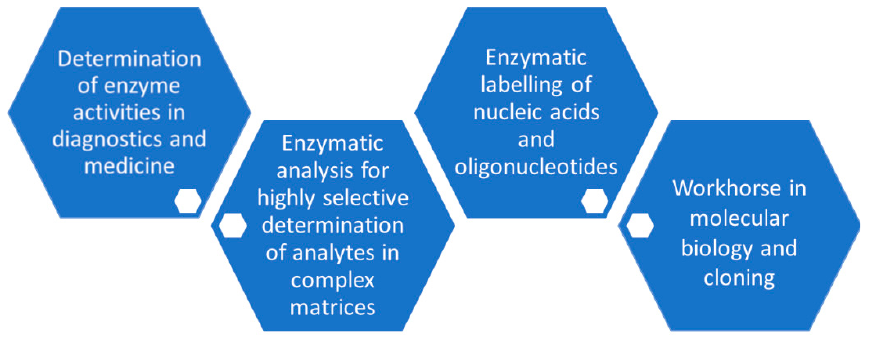
Figure 11. Major analytical application areas for phosphorylation